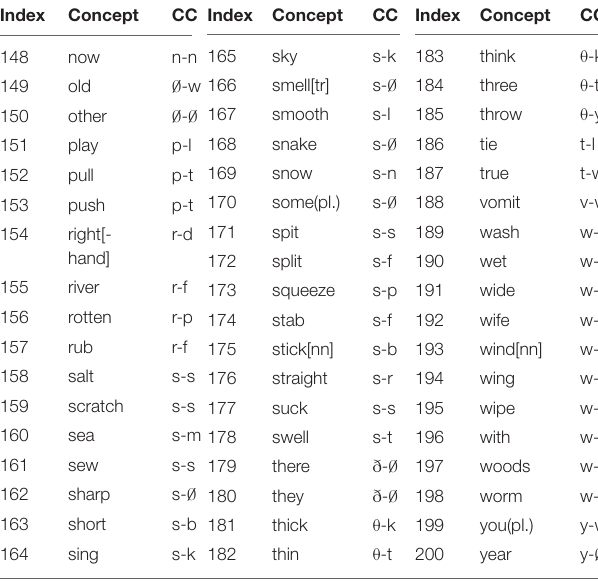
” denotes zero consonant. ∅